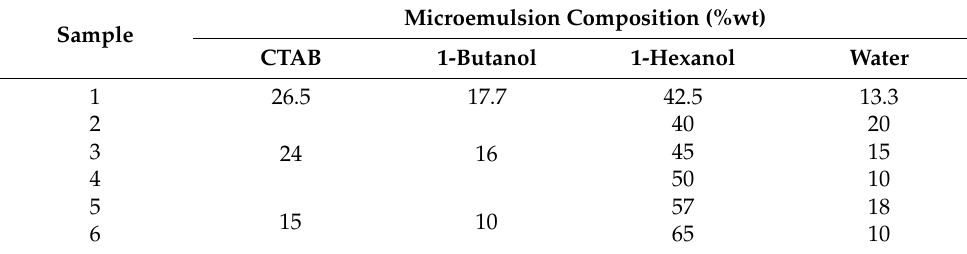
Table 1. Microemulsion composition (% wt) of the six formulations selected within the microemulsion stability region.